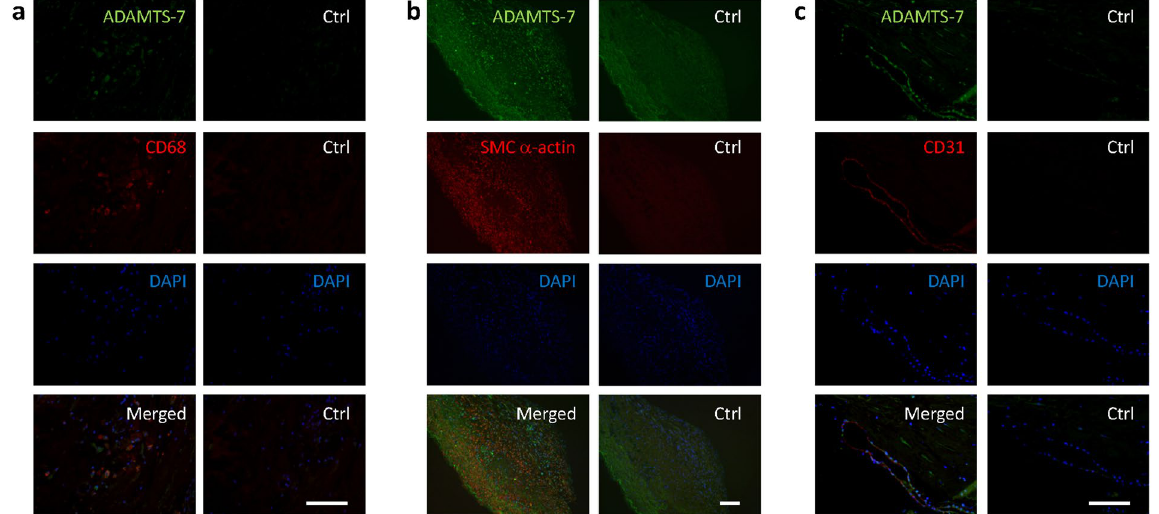
Figure 4. ADAMTS-7 co-stainings with CD68 ( a ), SMC α -actin ( b ), and CD31 ( c ). Human carotid plaque stained for ADAMTS-7 (green) and CD68 ( a ), SMC a-actin ( b ) or CD31 ( c ) (red), DAPI (blue) and merged together. Control sections are stained with isotype controls, DAPI, and merged. Scale bars: 10 µ